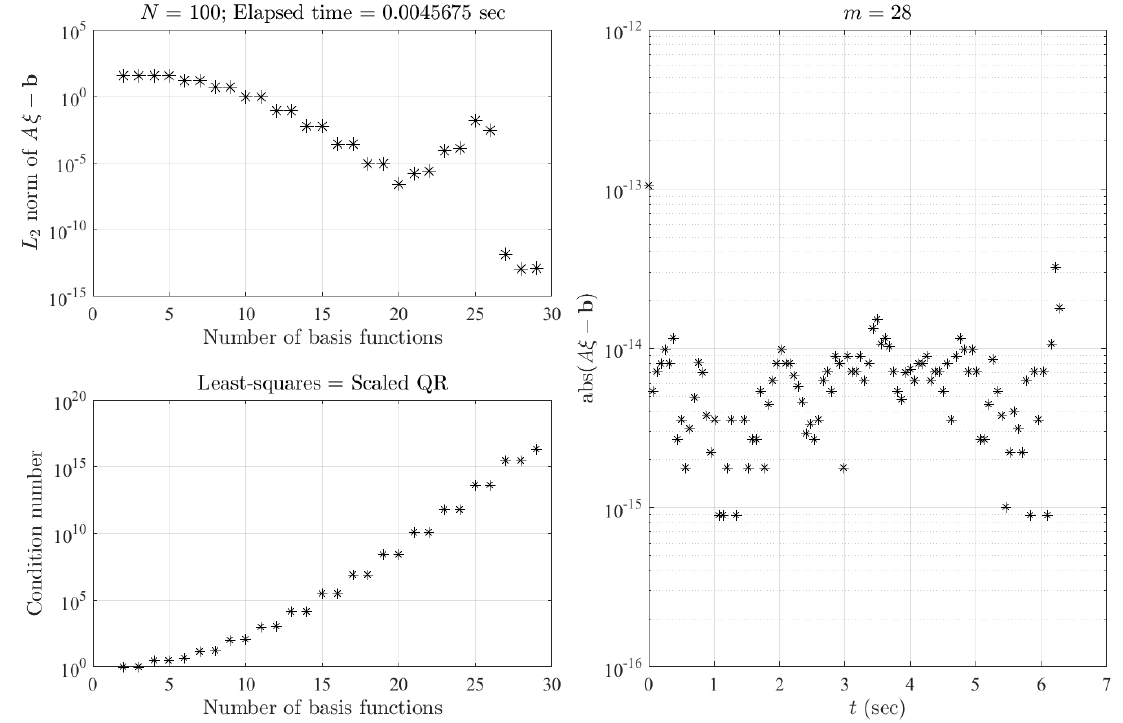
Figure 5. Least-squares-approach results (infinite